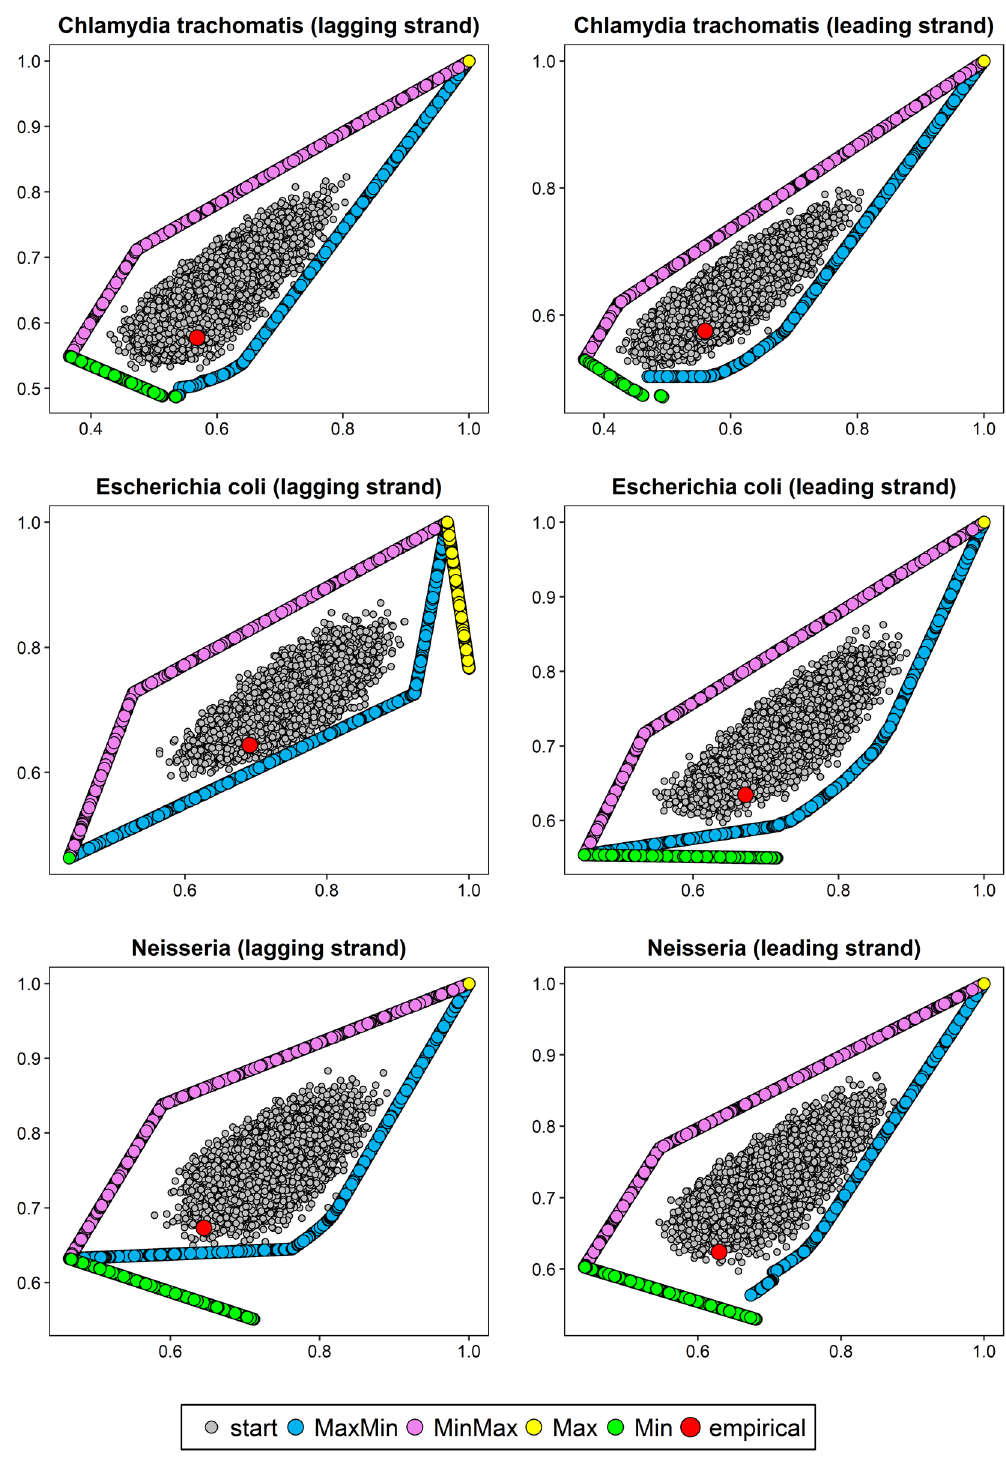
Figure 2. As in Fig.